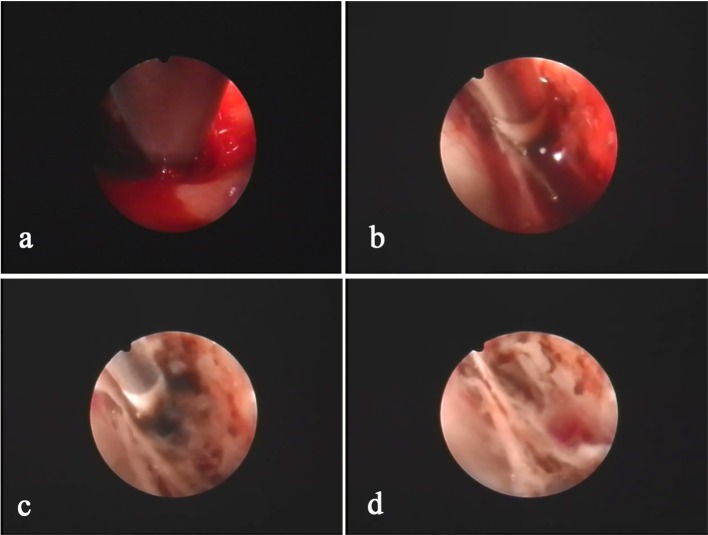
The hemorrhage sites inside the hematoma cavity are usually located at the folding point of the visceral layer and wall layer of the sac. The hemorrhage site (a) is identified after clearing the hematoma using an aspirator. Bleeding is precisely stopped using a specialized bipolar electrocoagulator on the endoscope (b,c). After hemostasis, the hematoma cavity is washed with warm saline to confirm hemostasis (d).